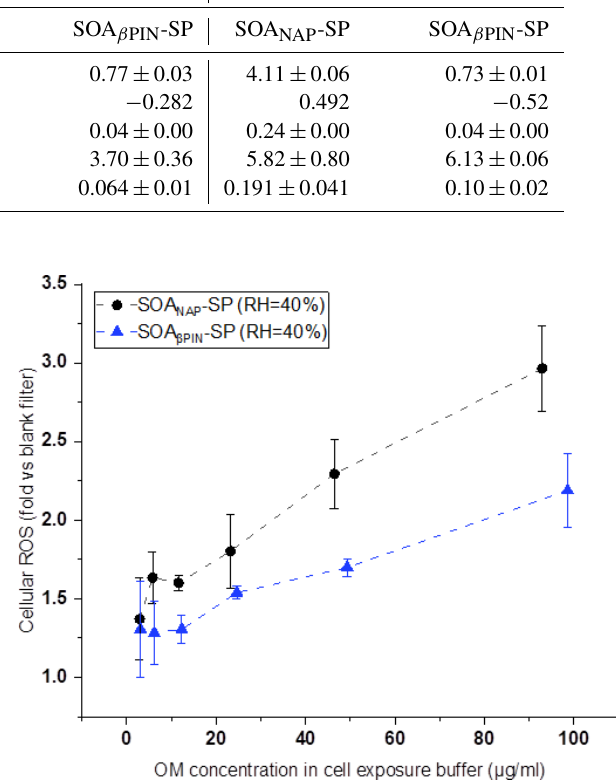
Figure 8. Variation of cell viability caused by exposing A549 cells to particle extracts. Exposure of the cells to particle extract concen- trations larger than 20µgmL − 1 of OM led to a significantly lower cell viability than exposures to a lower dose. Under the same ex- posure doses, the cell viability from SOA NAP -SP was significantly lower than that from SOA β PIN -SP, indicating that the naphthalene- derived SOA has a higher toxicity than β -pinene-derived SOA.